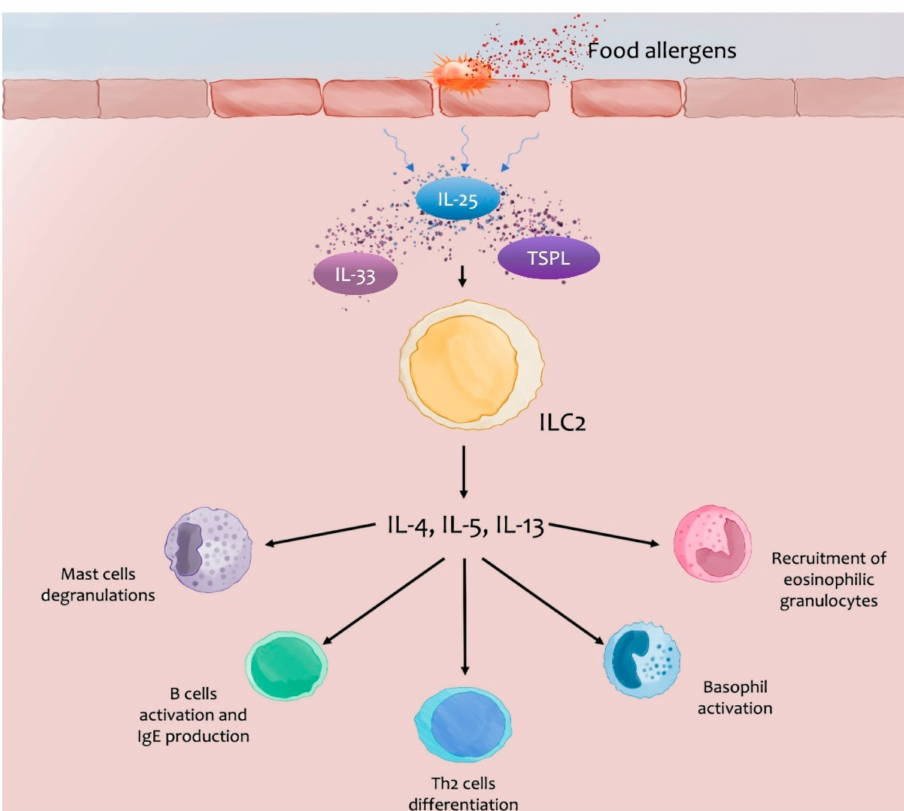
Figure 1. The damaged skin barrier or intestinal mucosa allows the passage of food allergens and subsequent sensitization. Furthermore, the damage causes the release of alarmins (IL-25, IL-33, and TSLP) that activate the ILC2 with the expansion and release of Th2 proinflammatory cytokines (IL-4, IL-5, and IL-13)